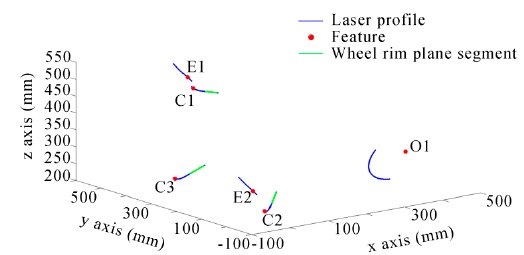
Figure 19. The 3D laser profiles.